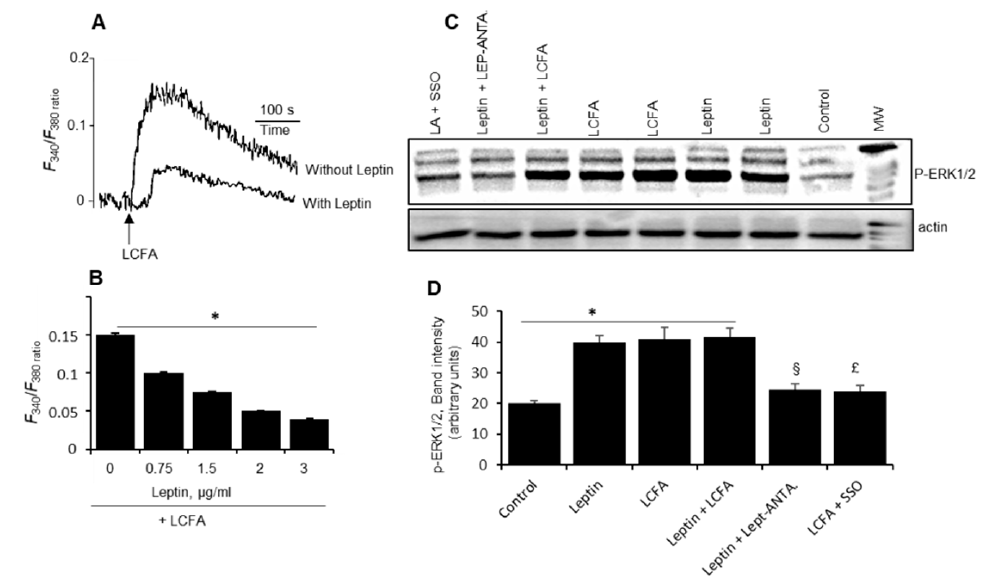
Figure 4. The effect of leptin on Ca 2+ and MAP kinase signaling. The freshly isolated mice TBC were loaded with Fura-2/AM and resuspended in Ca 2+ - containing medium as described in Materials and Methods. TBC were preincubated or not with leptin (1 µ g/mL) for 15 min at room temperature ( A ). The LCFA, i.e., linoleic acid (25 µ M), was added into the cuvette without interruptions in the recordings ( A ). The Y-axis represents the ∆ increases in [Ca 2+ ] i . The curves show the single traces of observations which were reproduced several times, independently ( n = 6). ( B ) shows the increases in [Ca 2+ ] i , induced by LCFA, in the presence or absence of increasing concentrations of leptin. Aster- isk shows the significant differences ( p < 0.001) compared to LCFA-induced response. ( C ) and ( D ) show ERK1/2 phosphorylation. The cells were treated with different agents [leptin, 1 μ g/mL; LCFA, 25 μ M; sulfo- N -succinimidyl oleate (SSO), 10 μ M; leptin antagonist (LEPT-ANTA), 10 nM] for 20 min with or without inhibitors, and then TBC were lysed and processed for western blotting. Aster- isk (in D ) shows the significant differences ( p < 0.001) compared with control (untreated cells). § and £ show significant differences ( p < 0.001), compared with, respectively, cells treated with leptin and LCFA alone. Histograms (in D ) show the relative band intensity (arbitrary units) of p-ERK1/2 meas- ured by densitometry of protein bands ( n = 5). Abbreviations: MAP, mitogen activated protein; MW, molecular weight. 3.3. Leptin Interacts with Cell Signaling Cascade and Induces Hyperpolarization Since leptin inhibited LCFA oro-sensory detection, we assessed different components of the cell signaling cascade in mice TBC. We explored Ca 2+ signaling, and noticed that LA-induced increases in [Ca 2+ ]i were decreased by prior incubation with leptin (Figure 4A,B). Leptin, indeed, decreased Ca 2+ signaling in a dose dependent manner (Figure 4B). Figure 4C shows that both leptin and LCFA induced the phosphorylation of ERK1/2 in mice TBC. The LCFA-induced ERK1/2 phosphorylation was mediated via CD36 as sulfo- N -succinimidyl oleate (SSO), a CD36 blocker, decreased the same. Similarly, the EKR1/2 phosphorylation, induced by leptin, was curtailed by Ob-Rb antagonist. However, both leptin and LCFA did exert an additive effect on ERK1/2 phosphorylation (Figure 4D). Leptin signaling involves STAT-3 phos- phorylation. Both LA and leptin triggered STAT-3 phosphorylation and there was no